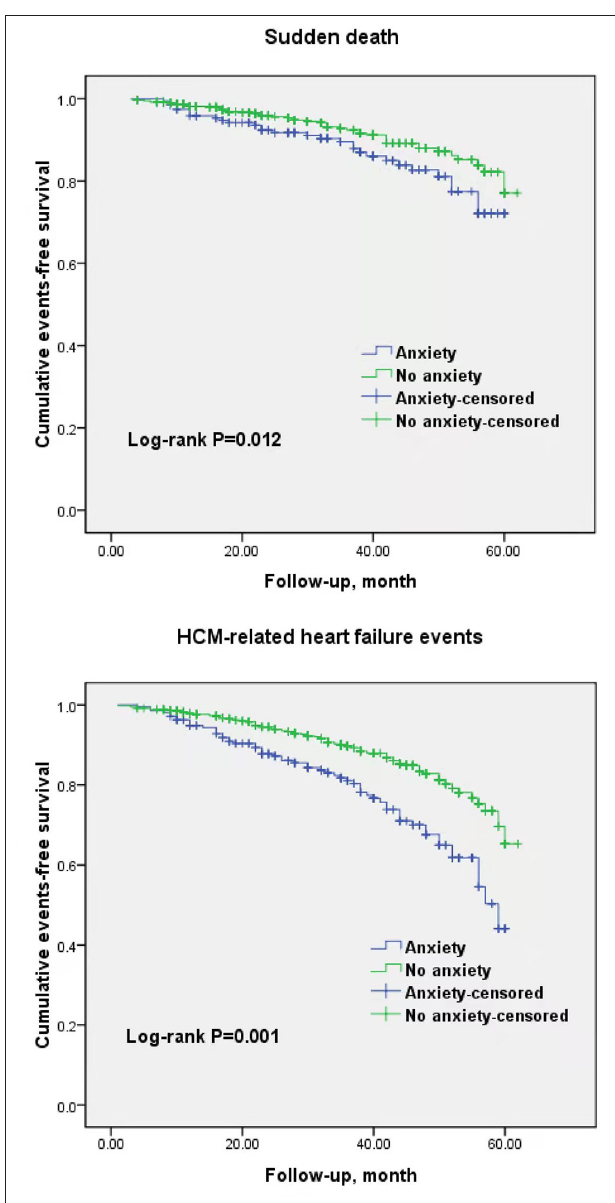
FIGURE 2 | Kaplan–Meier curves for sudden cardiac death events and hypertrophic cardiomyopathy related heart failure events in participants with and without